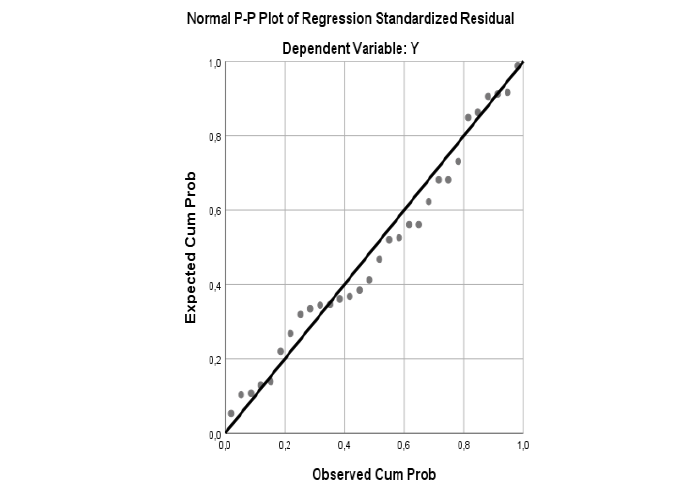
Figure 3: Normal P-P Plots